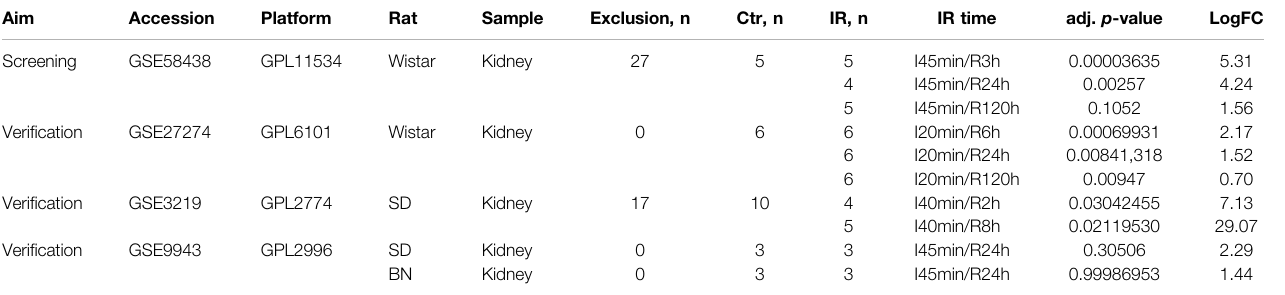
TABLE 1 | The details of datasets and the differential expression of HMOX1 at different time points.